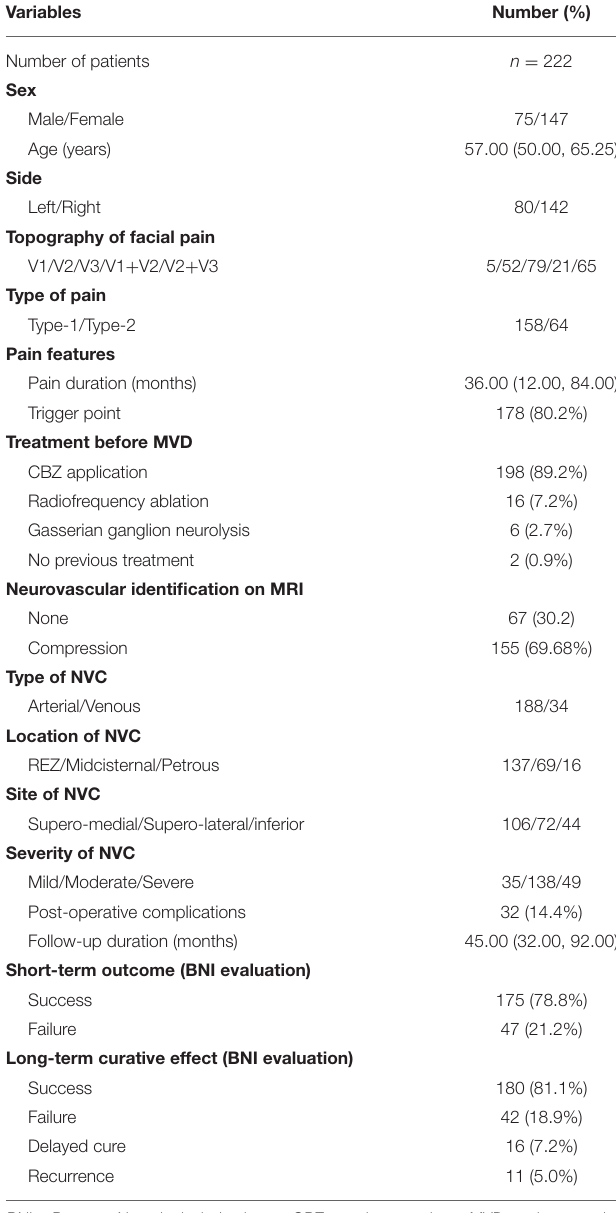
TABLE 1 | Clinical characteristics and outcomes of 222 classic TN